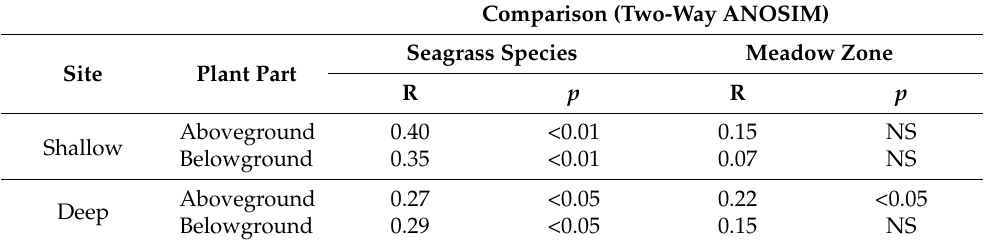
Table 4. Comparison of the seagrass-associated bacterial communities between seagrass species or meadow zones (two-way ANOSIM).